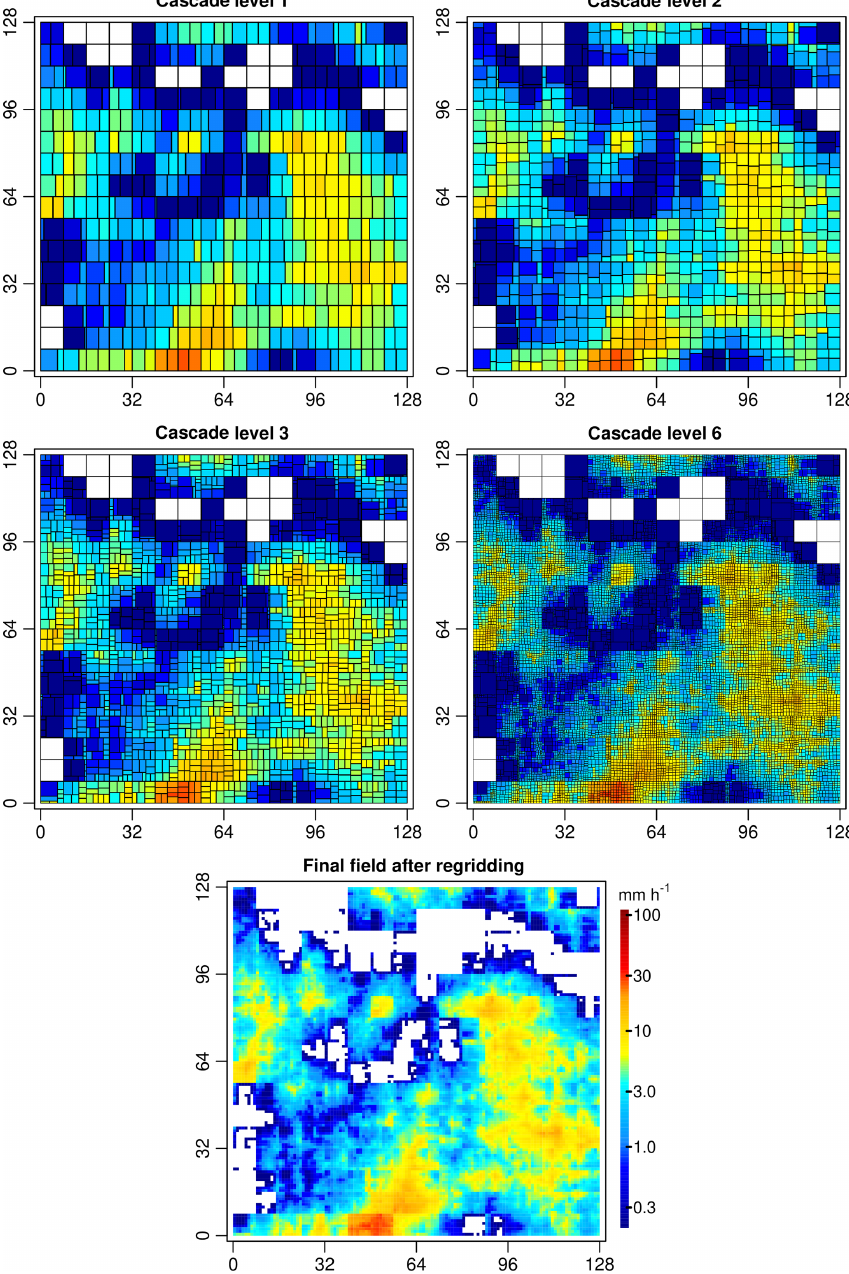
Figure 4. Example of an EVA cascade for an 8km × 8km input field with the size of 128km × 128km. In this example, the cascade was stopped after a fixed number of levels equal to six. The output was then resampled over a regular 1km × 1km Cartesian grid. All rainfall rates below 0.1mmh − 1 (after resampling) are assumed to be undetectable and are therefore displayed in white. Note how some grid cells converge to a fixed area during the cascade while others converge to a fixed